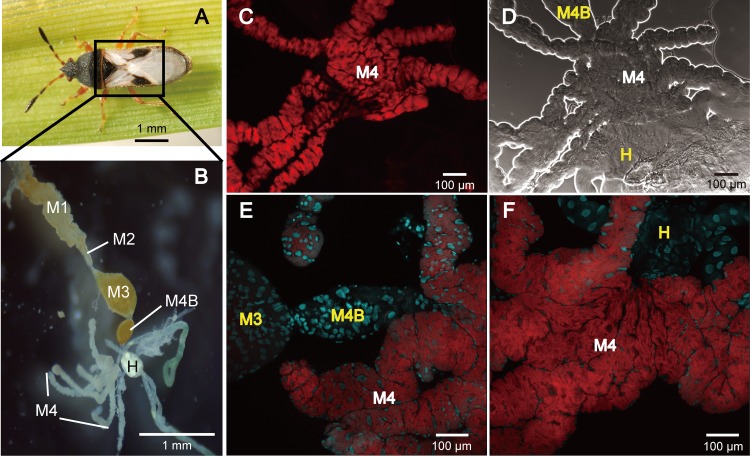
Visualization of Burkholderia in the digestive tract of Blissus insularis.(A) An adult B. insularis. (B) Dissected digestive tract. (C) Epifluorescence micrograph of FISH targeting Burkholderia 16S rRNA gene (red) in M4. (D) Phase contrast micrograph of the same areas. (E-F) Focus stacked laser scanning confocal micrographs of FISH localization of Burkholderia (red) in M4. Cyan signals indicate host nuclei stained with DAPI. Abbreviations: M3, midgut third section; M4, midgut fourth section with crypts; M4B, M4 bulb; H, hindgut. The labeling corresponds to that used for Cavelerius saccharivorus [12].